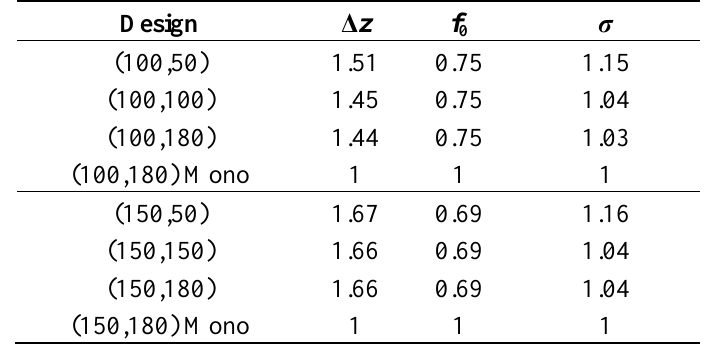
Table 2. Normalised deflection, frequency and stress results in different ( l , l microcantilever